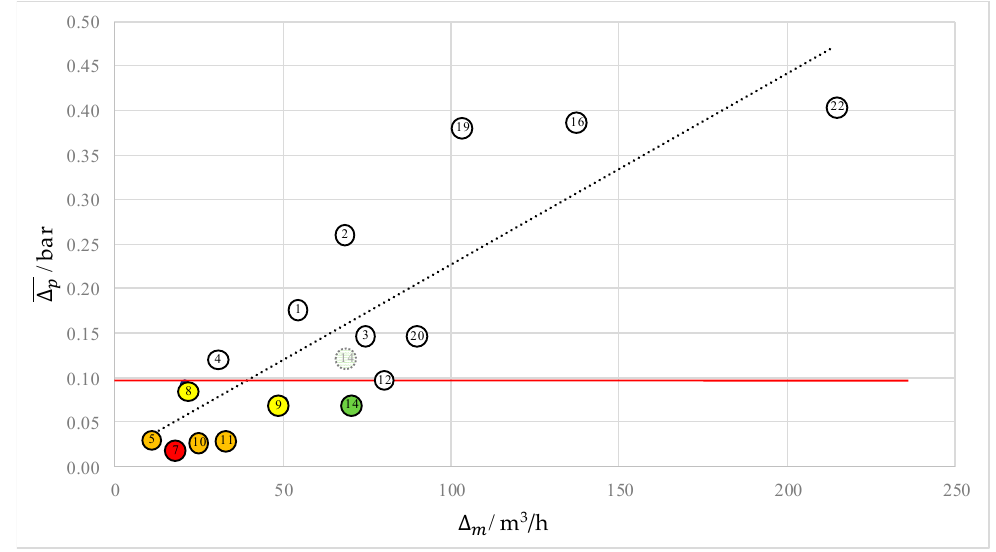
Figure 5. Comparison between pressure and refill mass flow level differences for each event.